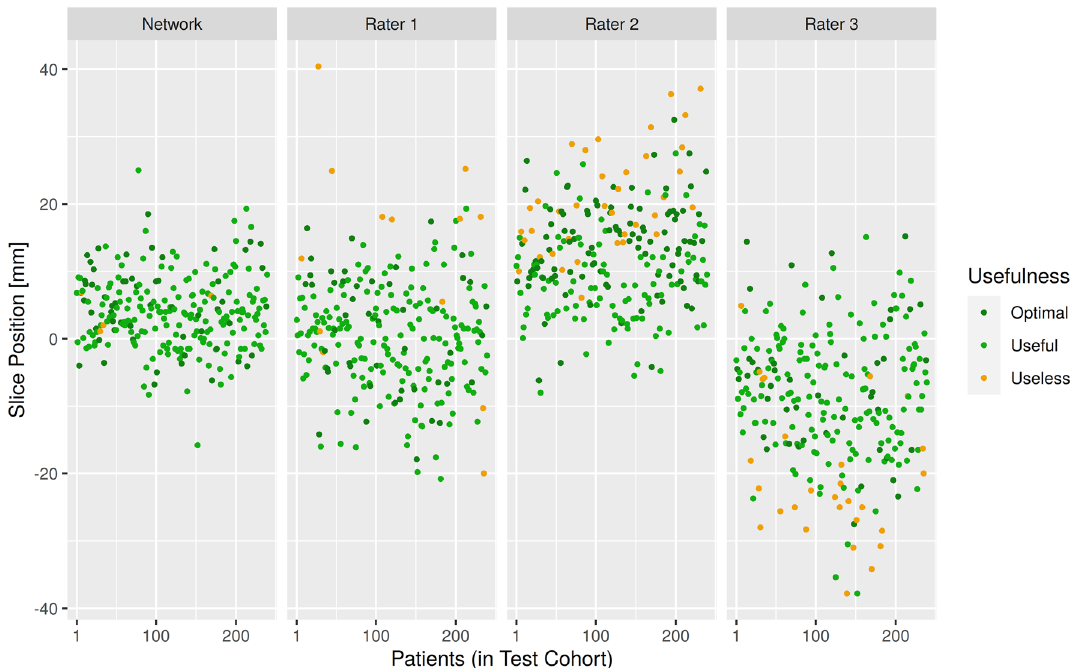
Figure 3. A visualization of the usefulness of the estimated slice positions of the pulmonary trunk of all radiographers and the predicted slice positions of the network on the test cohort. Slice positions are relative to the optimal slice position, which is different for each